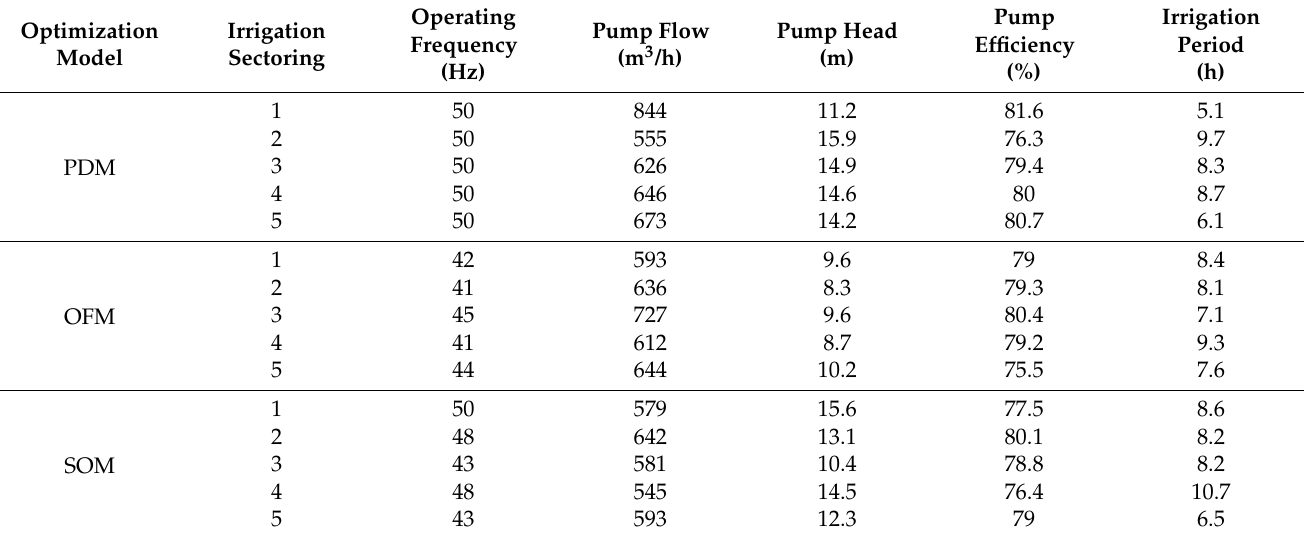
Table 5. Operating frequency, pump performance and irrigation period for all irrigation sectoring of different irrigation models.